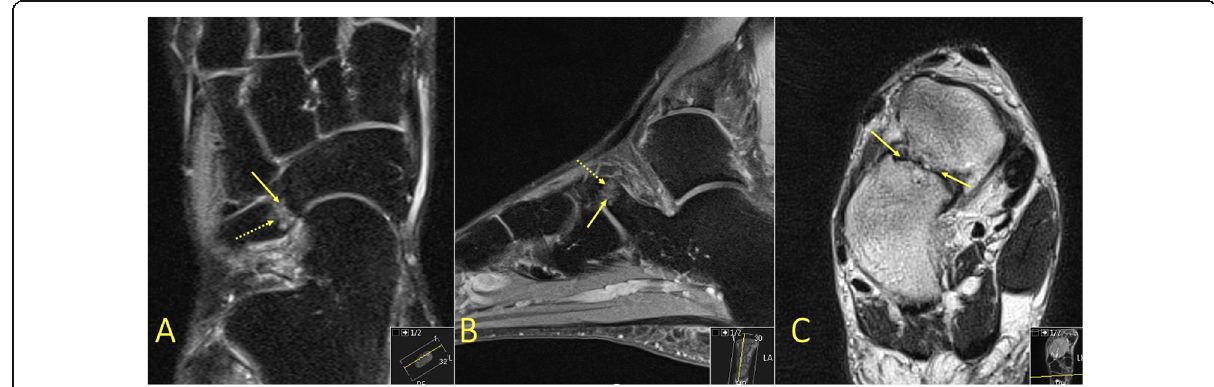
coalition (arrows) with adjacent BME (dashed arrow)